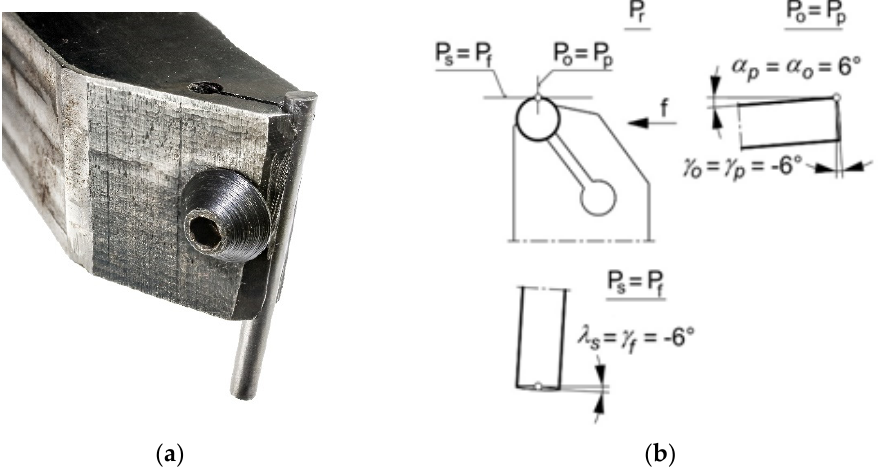
Figure 11. Prototype of the special tool with its cylindrical insert: ( a ) view of tool prepared using ATOS II Triple Scan; ( b ) geometry of cutting edge.